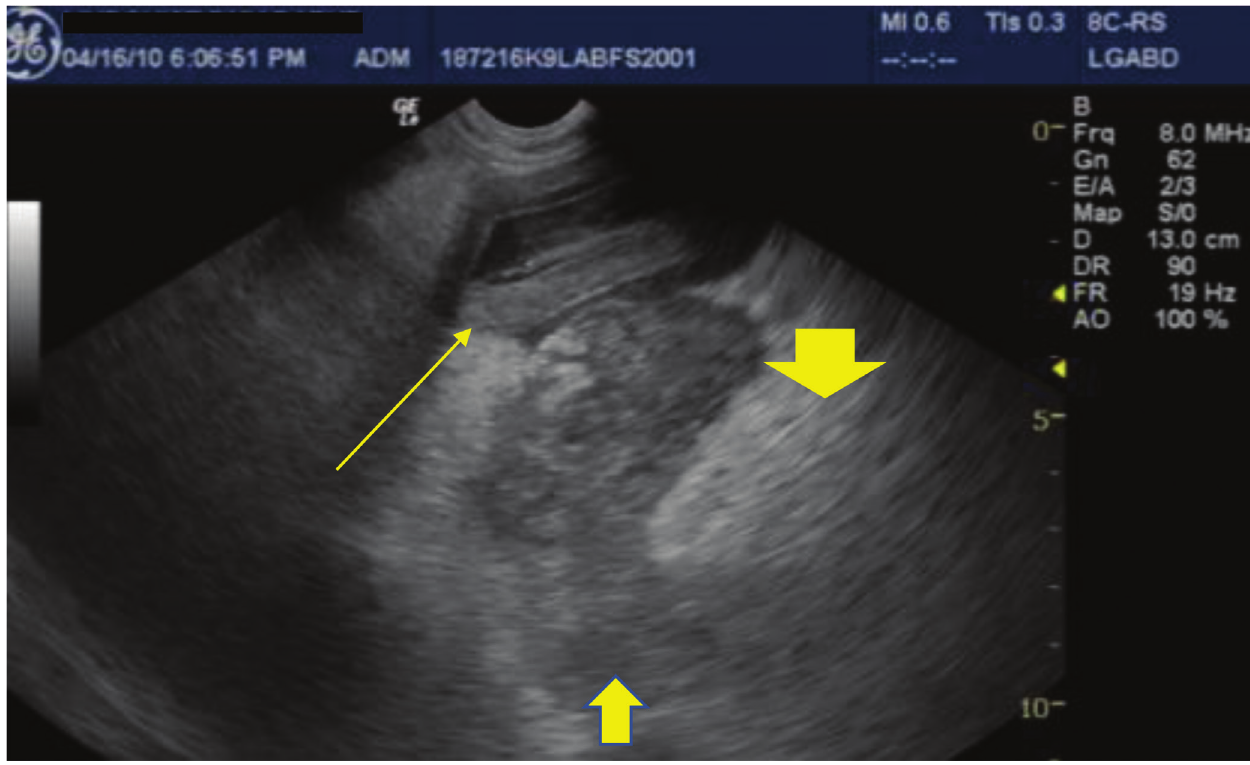
FIGURE 3: Example of pancreatitis affecting the right limb of the pancreas (group 2): Hypoechoic oedematous pancreatic parenchyma (middle arrow) and hyperechoic ill-defined surrounding fat (small thick arrow) consistent with saponification and inflamed mesentery. The upper descending duodenum in the near field is mildly oedematous and adjacent to the pancreatic inflammation (long thin